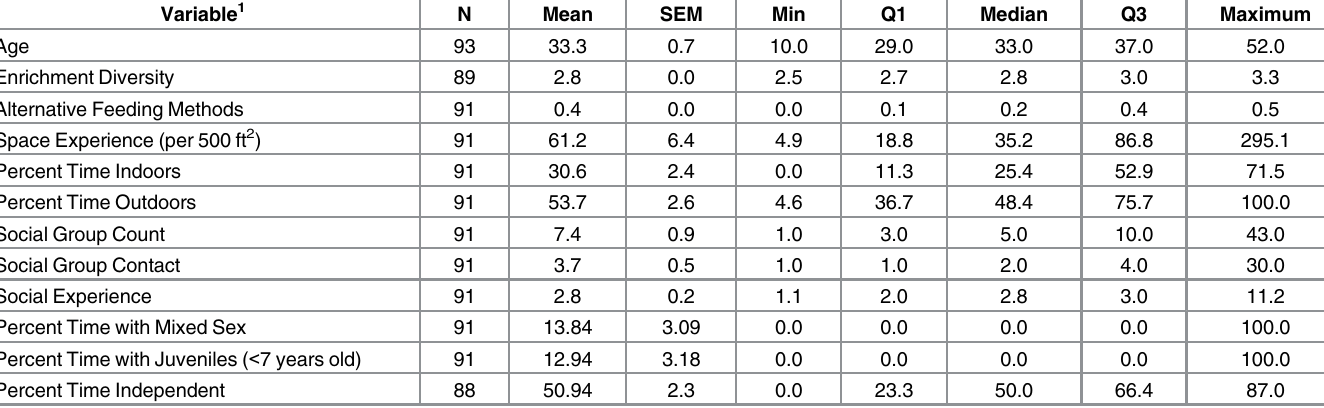
Table 10. Descriptive statistics for variables that were found to be significant in the hyperprolactinemia analyses for African elephants.